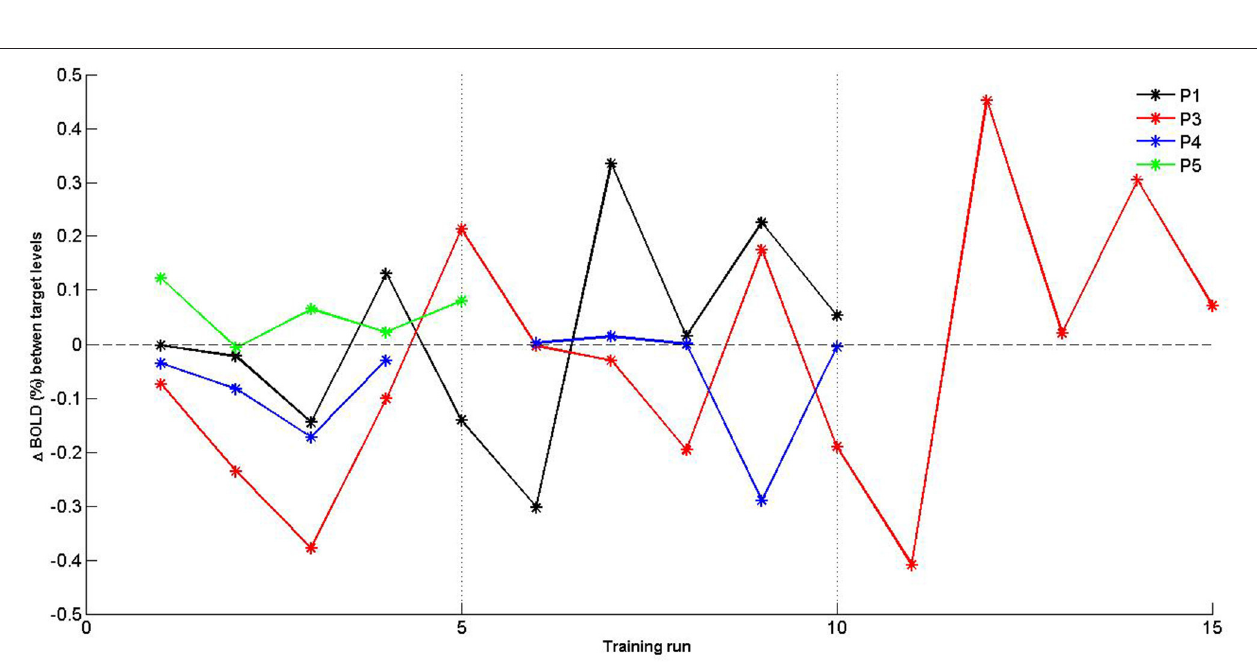
FIGURE 6 | Individual percent signal change (PSC) ( 1 BOLD) values of supplementary motor area (SMA) target level separation for training runs. Separate training sessions indicated by dotted vertical lines.